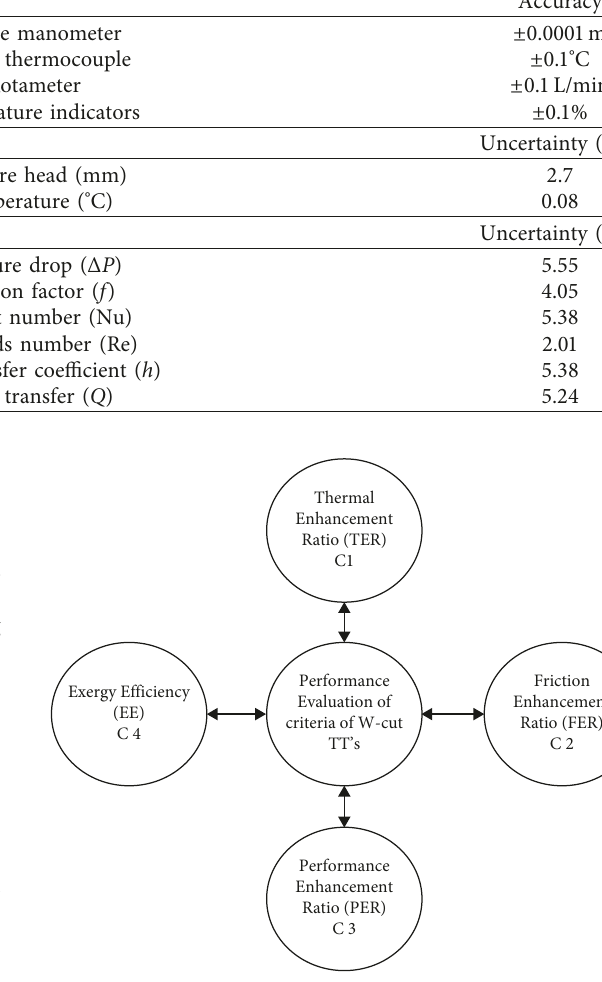
Figure 5: Different criteria for performance evaluation of grooved tube with W-cut twisted